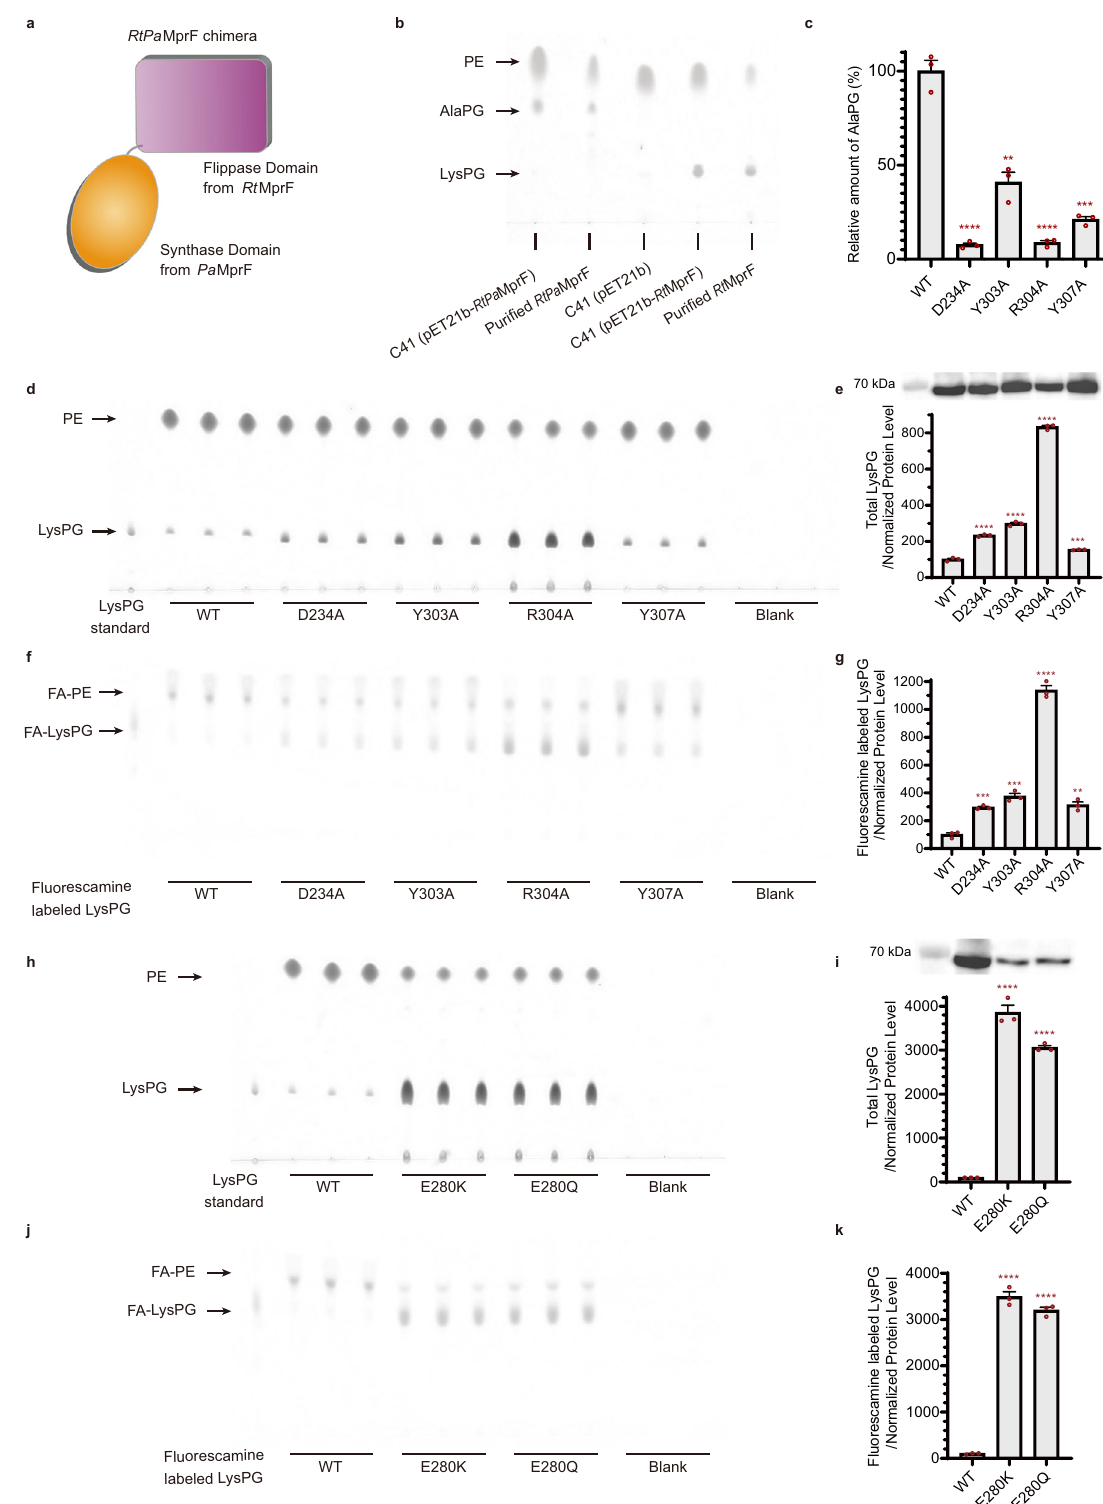
proteins have higher level of LysPG (per unit protein) than those protein. Similarly, the levels of LysPG on the outer lea fl et of with the wild-type protein (Fig. 4d, e), while the protein expres- membrane (accessible by the fl uorescamine dye) appear to be also sion levels are slightly variable among the wild type and mutants higher for the mutants than for the wild type (Fig. 4f, g). Fluor- (Fig. 4e). Among the four mutants, the cells expressing R304A escamine is a membrane-impermeable dye mainly reacting with mutant exhibit the highest level of total LysPG, while those with the LysPG exposed on cell surface (on the outer lea fl et) and was Y307A mutant have lower level of total LysPG than the other previously used for characterizing the in vivo fl ippase function of three mutants but are still 1.5 times of those with wild-type Sa MprF in S. aureus 9 . NATURE COMMUNICATIONS| (2021) 12:2927